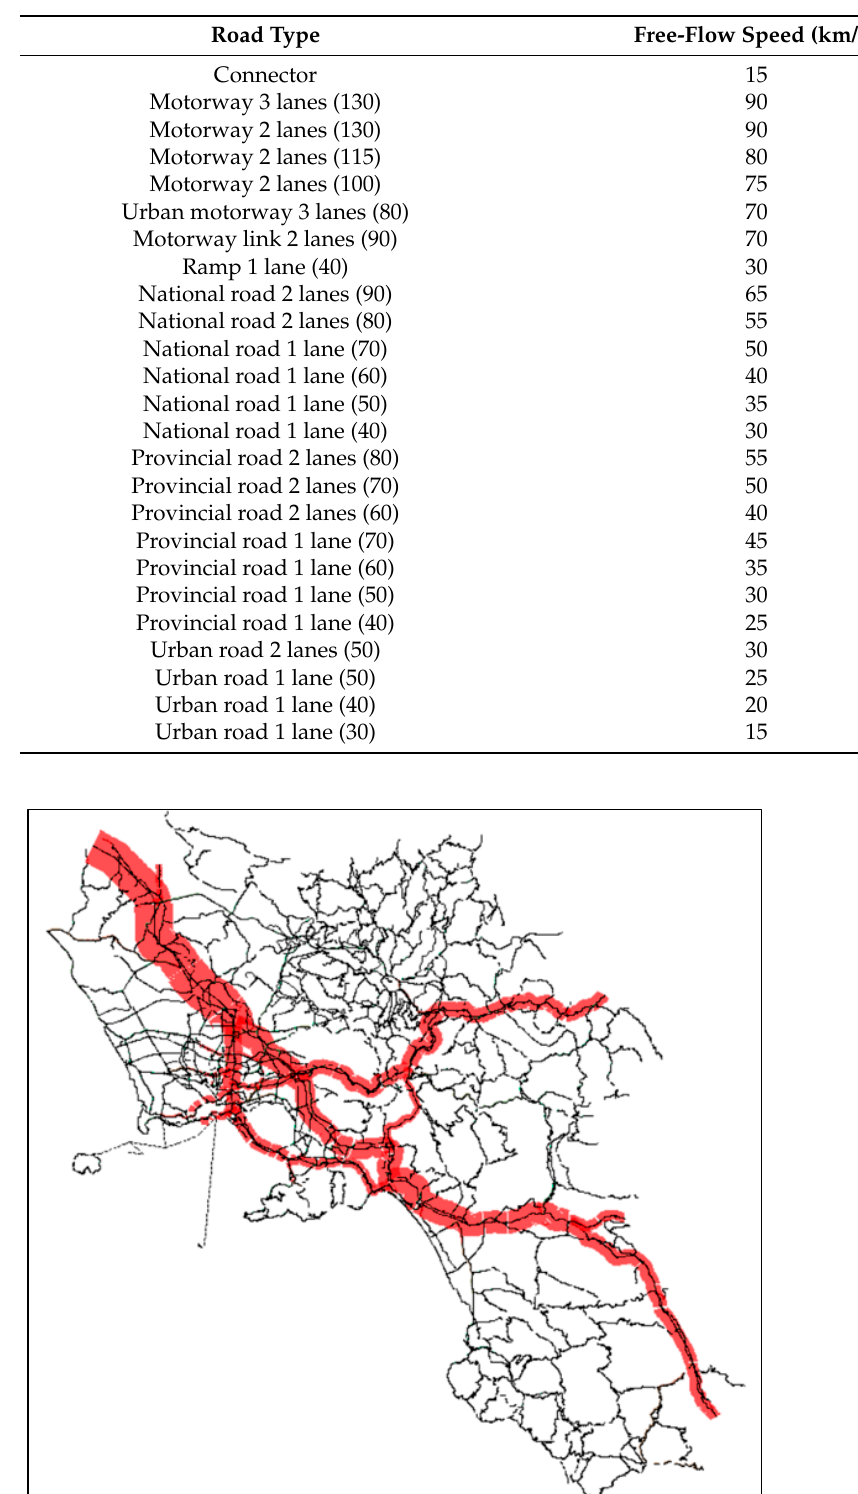
Table 4. Free-flow speed for HGVs (regional model) [4].